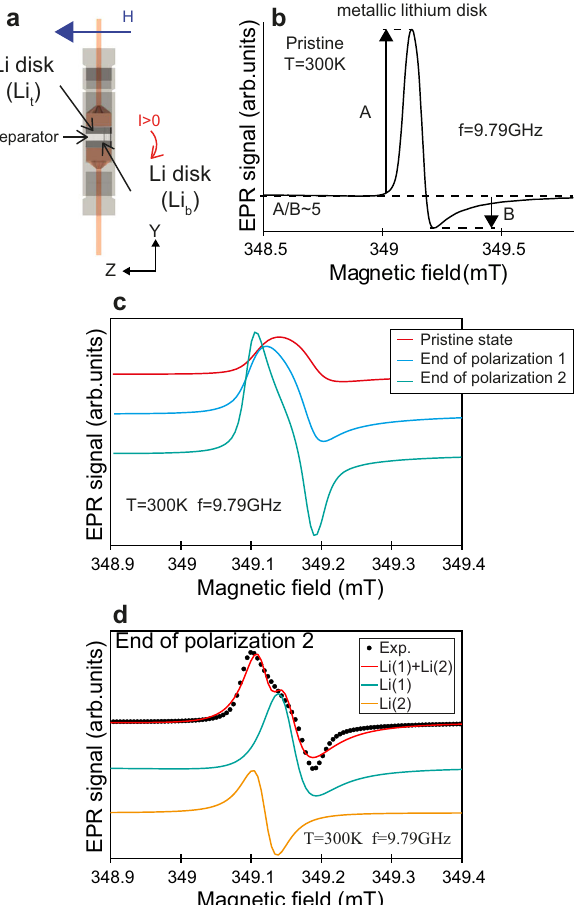
Fig. 1 Operando EPR spectroscopy recorded at 9.79 GHz. a Schematic representation of the EPR electrochemical cell and its orientation in the external magnetic fi eld H created by Charles-Emmanuel Dutoit using an open-source 3D computer graphics software (Blender 3D). Y and Z are the magnetic fi eld gradient directions for imaging. b cw-EPR spectrum of a pristine metallic lithium disk (no cycling). A and B denote the amplitude of the positive and negative parts of the EPR line, respectively. c Selection of operando cw-EPR spectra of the Li/LiPF 6 /Li cell. A symmetrical and sharp EPR line appears in the low magnetic fi eld fl ank of the bulk signal upon polarization. d Experimental (black dots) and simulated (red line)